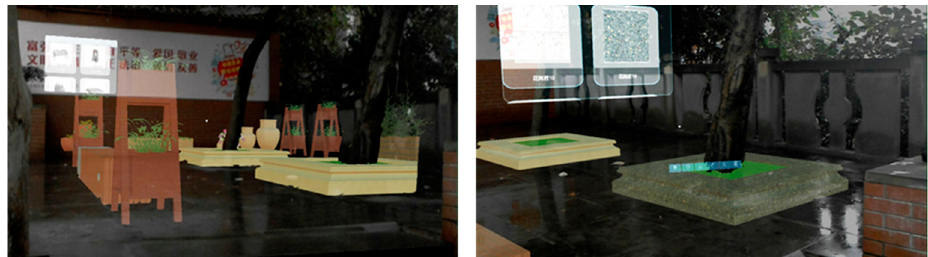
Figure 7. The 3D on-site visualization of the virtual design objects using MR.